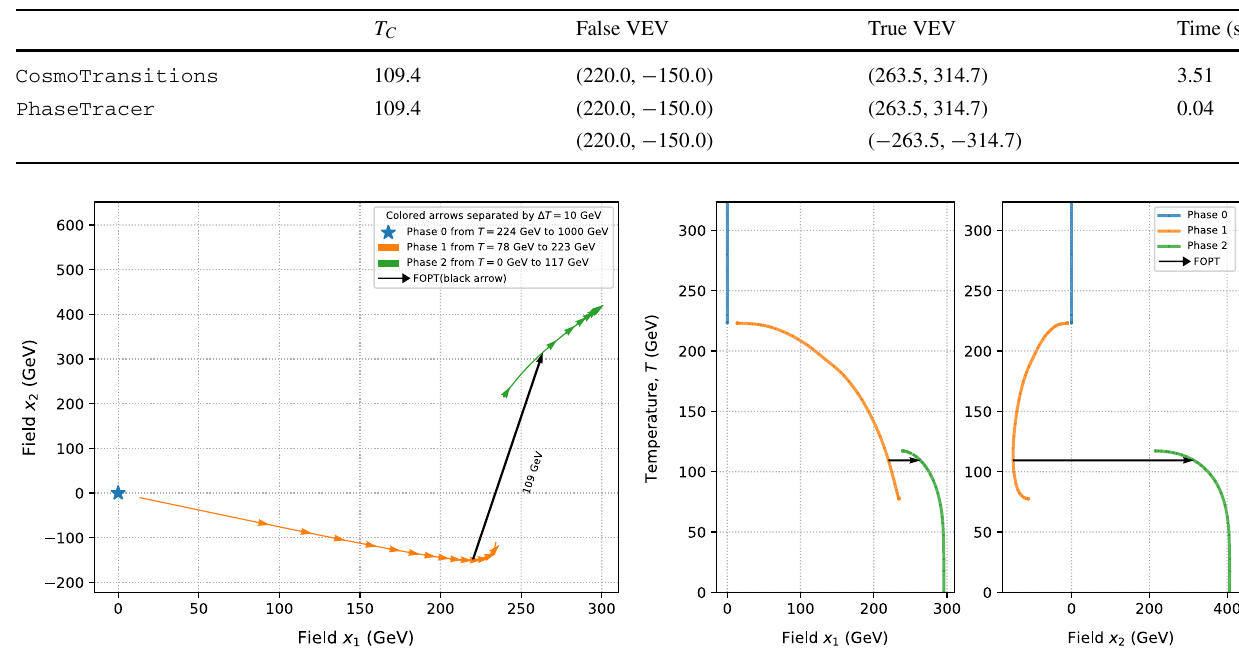
Table 3 Results and elapsed time of PhaseTracer and CosmoTransitions for the 2D test model. All dimensionful quantities are in GeV. The base of the VEV is (φ 1 ,φ 2 )